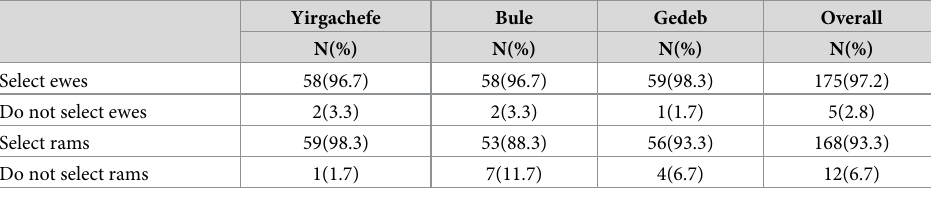
Table 7. Selection practices on ewes and